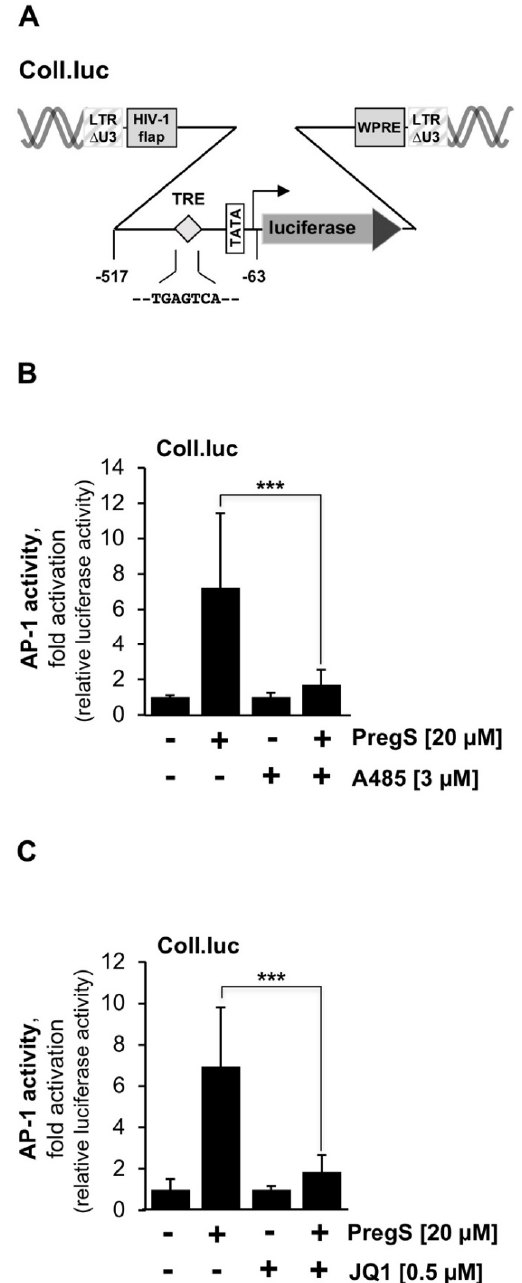
Figure 2. Pharmacological inhibition of CBP/p300 and BET proteins attenuates TRPM3-mediated activation of AP-1. ( A ) Provirus containing the Coll.luc (collagenase promoter/luciferase) reporter gene. The AP-1 DNA binding site (known as 12- O -tetradecanoylphorbol-13-acetate (TPA)-responsive element (TRE)) is indicated. The provirus contains a deletion within the 5 ′ LTR U3 region. Additionally, the provirus contains the woodchuck hepatitis virus posttranscriptional regulatory element (WPRE) and the HIV flap element. ( B , C ) T-REx-TRPM3 cells were infected with a Coll.luc-containing recombinant lentivirus. Cells were incubated in a serum-reduced medium for 24 h that was supplemented with tetracycline (1 μ g/mL) to induce TRPM3 expression. Preincubation of the cells was performed for 3 h with either the histone acetyltransferase inhibitor A485 (3 μ M) ( B ), or the BET inhibitor JQ1 (0.5 µ M) ( C ). T-REx-TRPM3 cells were stimulated for 24 h with pregnenolone sulfate (PregS, 20 µ M) in the presence of the inhibitor. Cell extracts were prepared and analyzed for luciferase activities. Luciferase activity was normalized to the protein concentration. Data shown are mean +/ − SD of four ( B ) or three ( C ) independent experiments performed in quadruplicate (*** p <